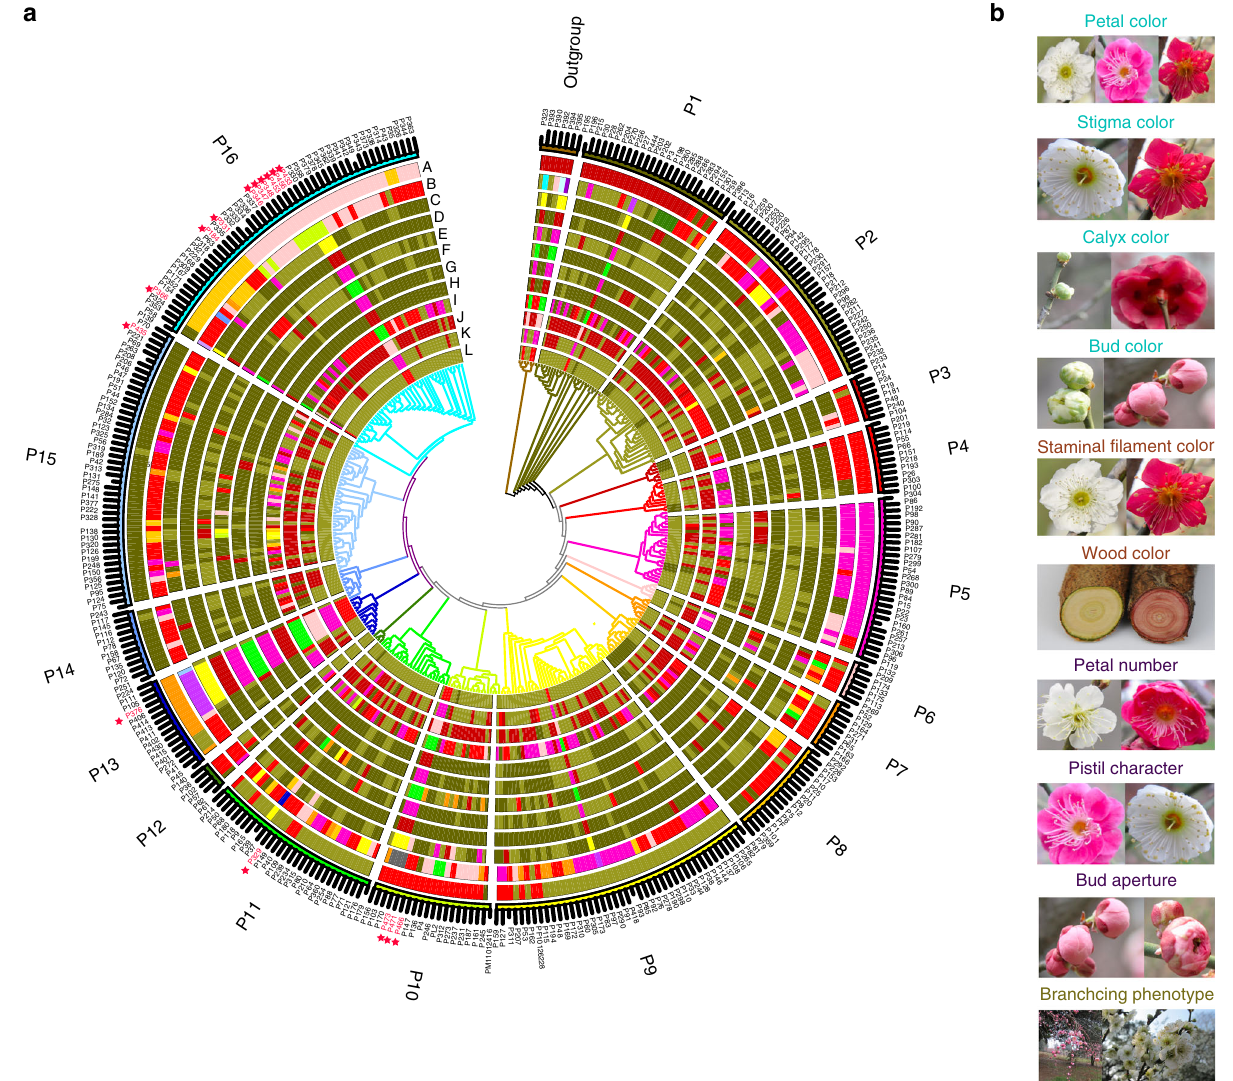
Fig. 1 Phylogenetic tree and ten representative traits of 348 mei accessions. a The inner phylogenetic tree contains 16 subtrees and one outgroup. Different colors represent different subtrees. The clade color corresponds to the color of the outer circle with sample ID. The intermediate circles from the outer circle to the inner circle (A – L) represent population structure, cultivar group, and the traits petal color, stigma color, calyx color, bud color, staminal fi lament color, wood color, petal number, pistil character, bud aperture, and branching phenotype. The color in each circle represents the phenotype of the trait. b Images of several representative phenotypes of these 10 traits (photographed by